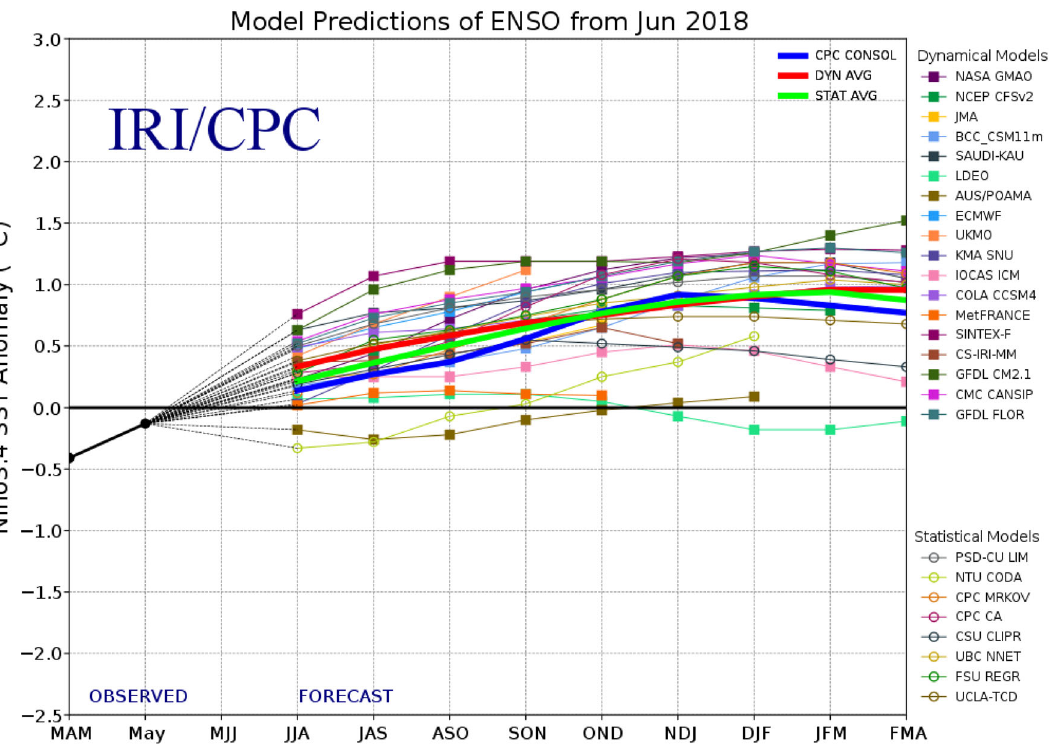
Fig. 3 Example of multiple model predictions and probability forecast of ENSO, June 2018. MAM March–April–May, and so forth. Source : IRI (2018) Fig. 4 Schematic by Glenn Becker in 2015, as shown on the ENSO Blog. Source : Becker